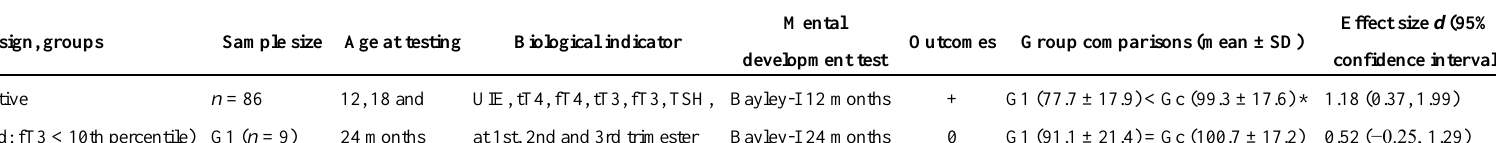
Table 2. Cohort prospective studies stratified by maternal iodine